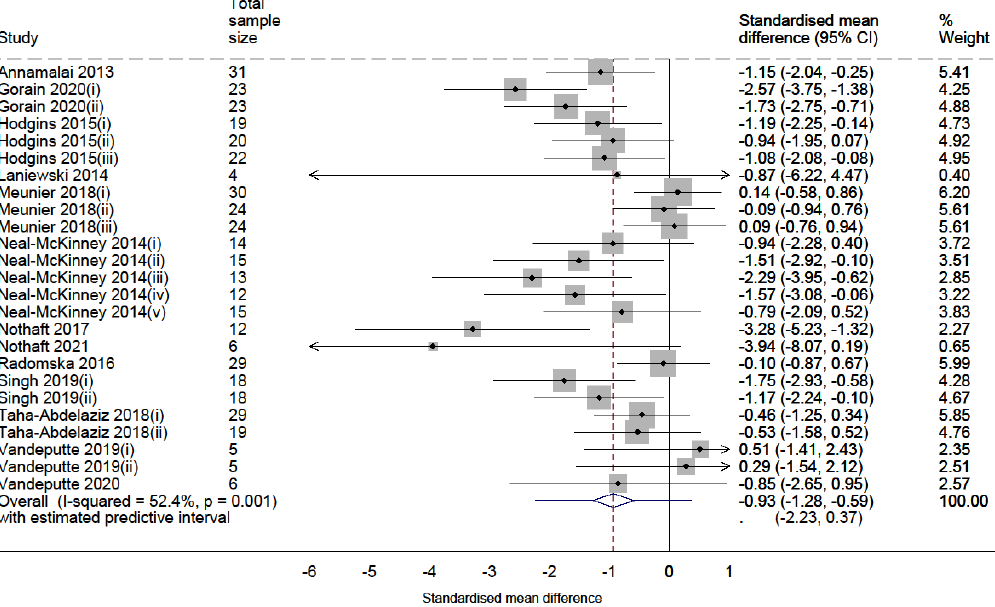
Figure 2. Random effects meta-analysis forest plot synthesising the effects of vaccinating meat chickens against Campylobacter [35–47]. Each point represents the calculated SMD of each comparator with whiskers representing the 95% confidence interval. Each box represents the weight percentage that each study contributes to the final pooled estimate. The middle of the diamond (bottom) represents the pooled estimate, and the sides represent its 95% confidence interval. The whiskers at either side of the diamond represent the estimated predictive interval.